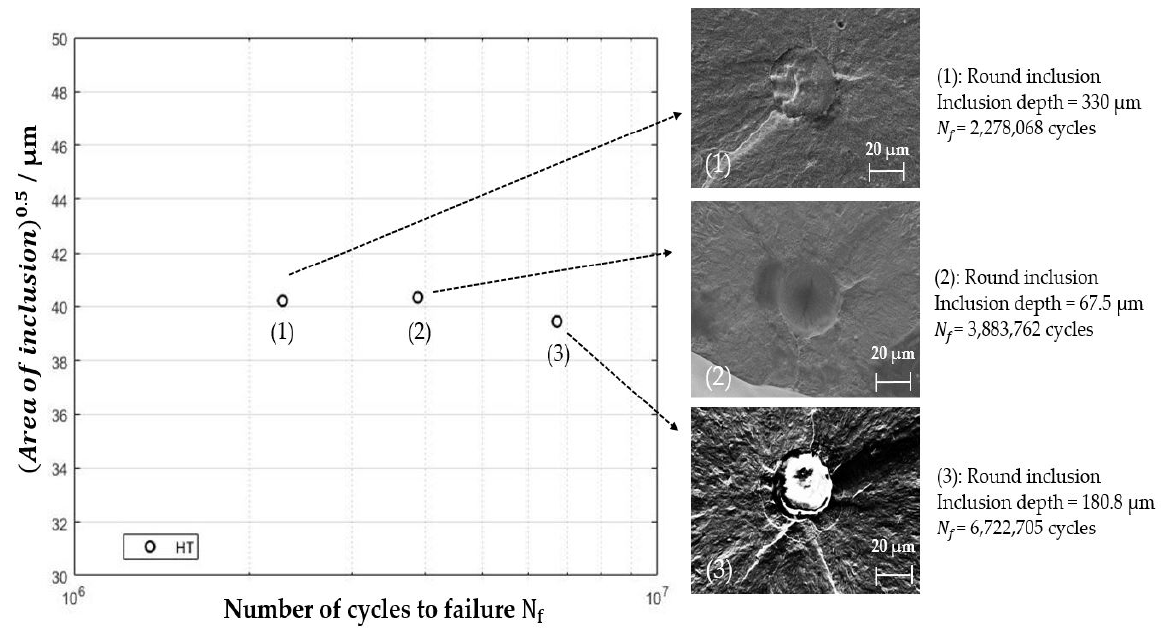
Figure 8. Evaluating the effect of inclusion depth on the lifetime for HT specimens at σ a = 775 MPa.